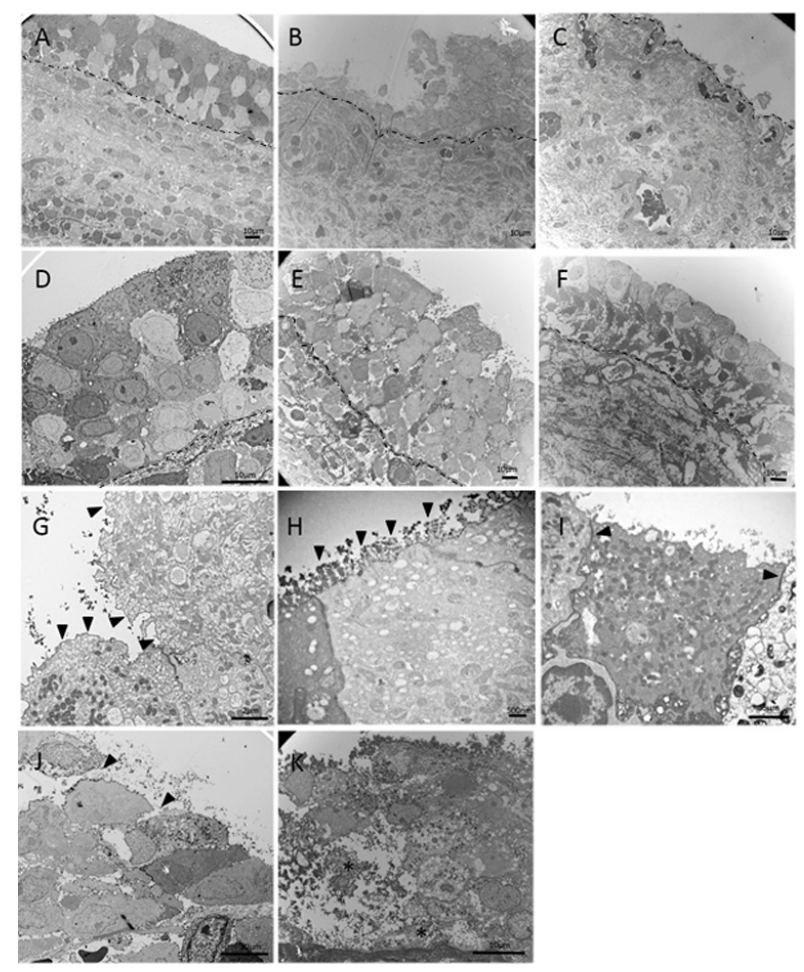
Figure 1. Representative images of various grades of EM bladder epithelial cell defects in the patients with DU. ( A ) Normal intact epithelium with 3–7 cell layers; ( B ) mild epithelial denudation; ( C ) completely denudated epithelium; ( D ) normal epithelial intercellular space; ( E , F ) mild and se- vere enlarged epithelial intercellular spaces (indicated by asterisks, *); ( G ) apical umbrella cell uro- plakins (black triangle); ( H ) apical umbrella cells with microvilli (black triangle); ( I ) epithelial cells with intact tight junction complexes (black triangle); ( J ) epithelial cells without tight junction com- plexes; and ( K ) lysed epithelium cells. Dotted lines indicate the basement membrane. On EM, DU lamina propria specimens exhibited various grades of loose extracellular connective tissue density, lymphocyte infiltration, and broken blood vessels (Table 2 and Figure 2). Lamina propria nerve terminals were only found in 6 of the 25 (24%) DU blad- ders (Figure 2H), whereas they were observed in 3 of the 4 (75%) control bladders. Telo- cytes were only found in two DU bladders (Figure 2I). Detrusor muscles were noted in 12 of the 25 DU bladders and all control bladders. The control detrusor muscle cells in EM